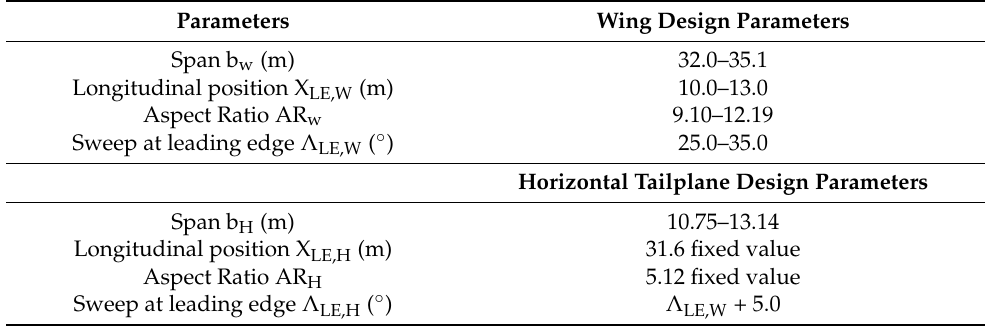
Table 8. Variables design space for the regional jet model designed on a 1600 NM mission